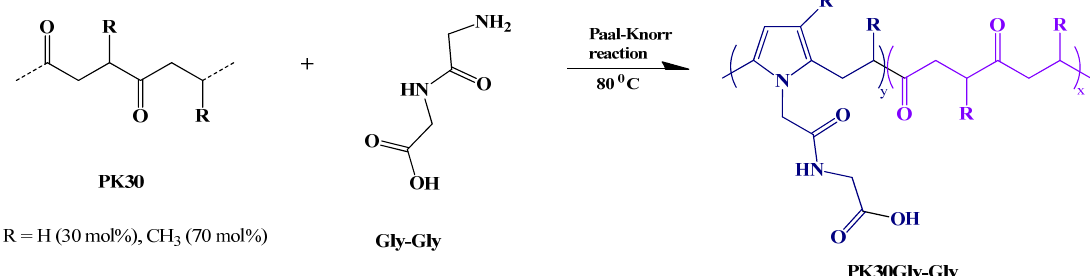
Figure 1. Scheme of Paal–Knorr reaction held by polyketone 30 (PK30) and glycyl-glycine (Gly-Gly).